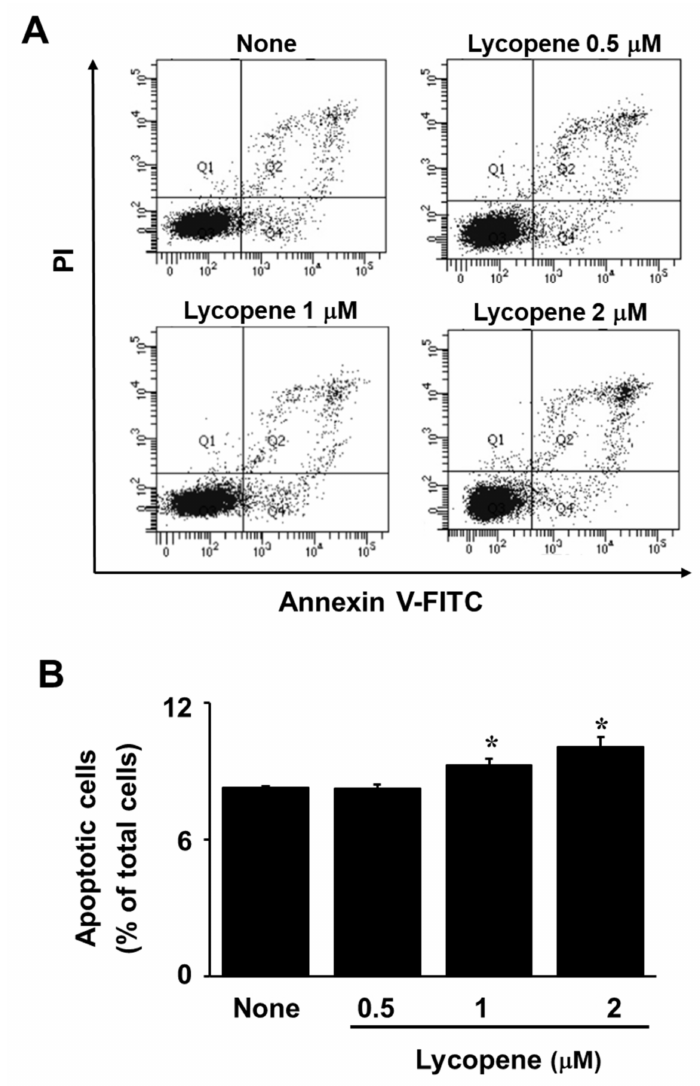
Figure 2. Lycopene induced apoptosis of AGS cells. ( A ) Flow cytometric analysis results of lycopen-induced apoptosis in AGS cells at di ff erent concentrations of lycopene are shown. ( B ) A bar graph of fluorescein isothiocyanate (FITC)–labeled annexin V / propidium iodide (PI) staining is shown. Apoptotic cells included the Annexin V + / PI − cells (early apoptosis) and the Annexin V + / PI + cells (late apoptosis). * p < 0.05 versus the cells treated with a vehicle tetrahydrofuran without lycopene